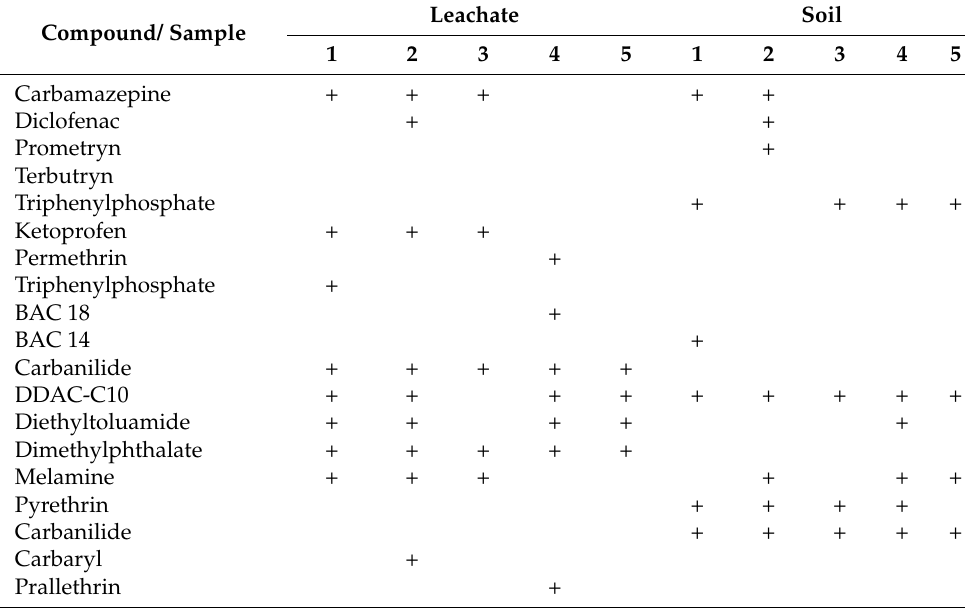
Table 6. Toxic compounds found in leachate and soil samples with the TargetScreener measure- ment